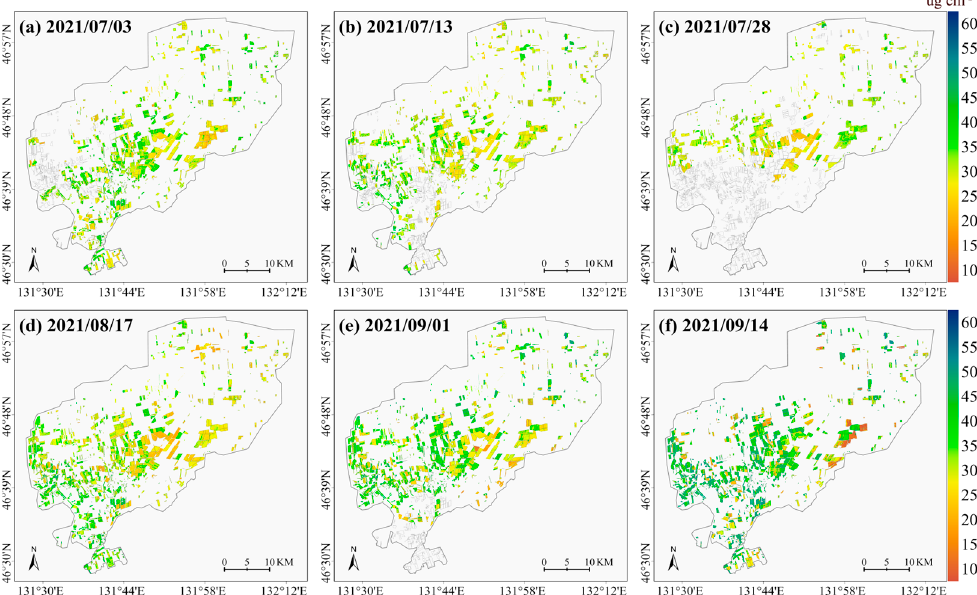
Figure 7. Maize LCC maps of Youyi farm obtained from Sentinel-2 imagery on ( a ) 3 July, ( b ) 13 July,